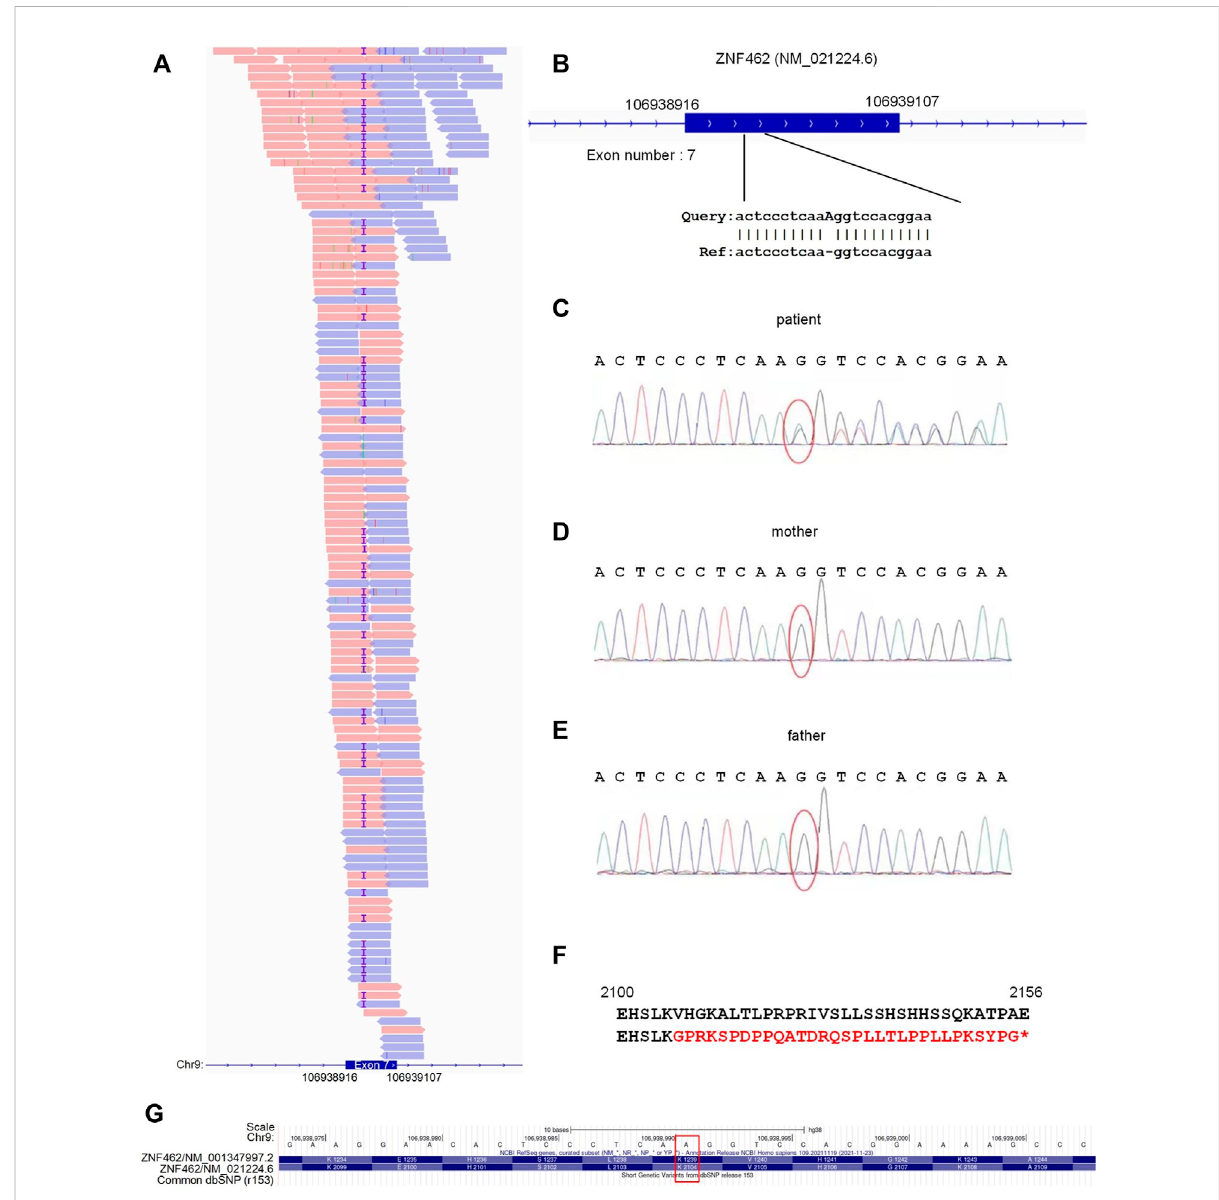
FIGURE 1 Identi fi edmutationlocusof ZNF462 inthepatient. (A) Locusoftheadenosineinsertionin ZNF462 andtheexomesequencingreadsatthelocus. The reads marked with purple “ I ” s are those with the adenosine insertions. (B) Insertion of adenosine occurs in the seventh exon of ZNF462 (NM_021224.6). (C – E) Sanger sequencing results of the patient and his parents. Red ovals indicate the insertion site of adenosine. (F) Amino acid sequences of ZNF462 without (up) and with the adenosine insertion (down). In the mutated ZNF462 amino acid sequence, the adenosine insertion causes a variation from Val to Gly and different subsequent amino acids, and introduces premature translation terminations. (G) When compared with the dbSNP (r153) in the UCSC Genome Browser, the identi fi ed insertion site of adenosine was not a known SNP, as indicated by the red